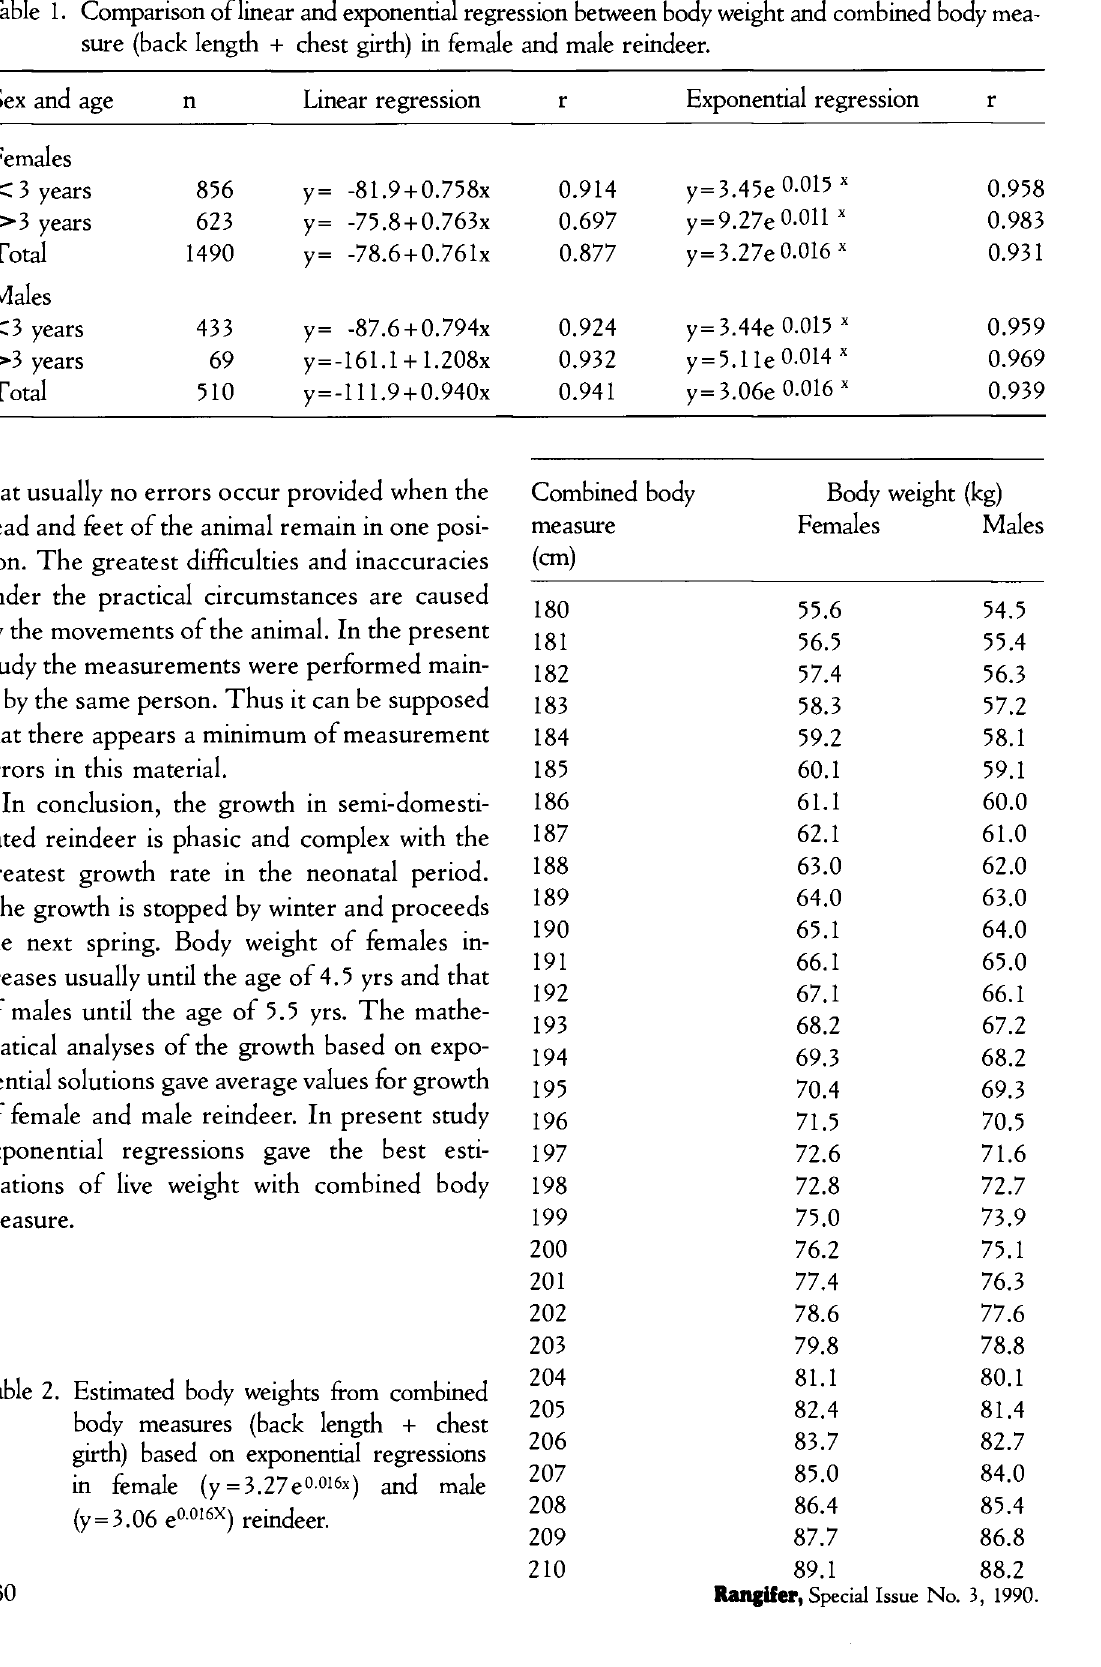
Table 2. Estimated body weights from combined body measures (back length + chest girth) based on exponential regressions in female (y = 3.27e 0016x ) and male (y=3.06 e 0016X )